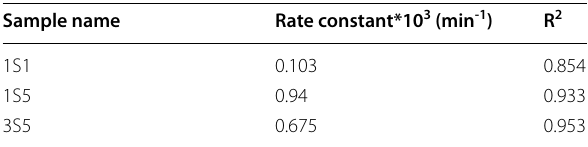
Table 1 Rate constant and R 2 values obtained from the linear fit of the logarithmic plot of (C /C) versus time for different nano- 0 fluid samples used to degrade 20 µM/L Rhodamine B